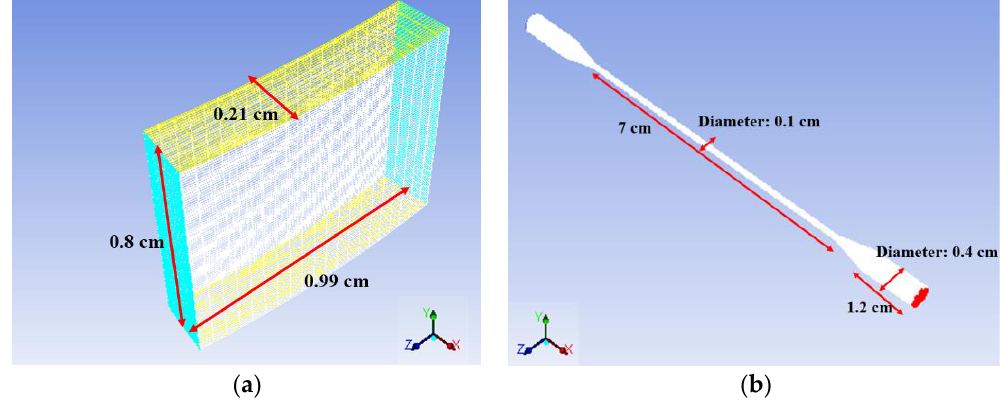
Figure 1. ( a ) 3D computational model of 1/32nd of the viscometer used in Sutera and Mehrjardi [16]; ( b ) 3D model of the capillary tube used in Kameneva et al. [4]. ( b ) 3D model of the capillary tube used in Kameneva et al.